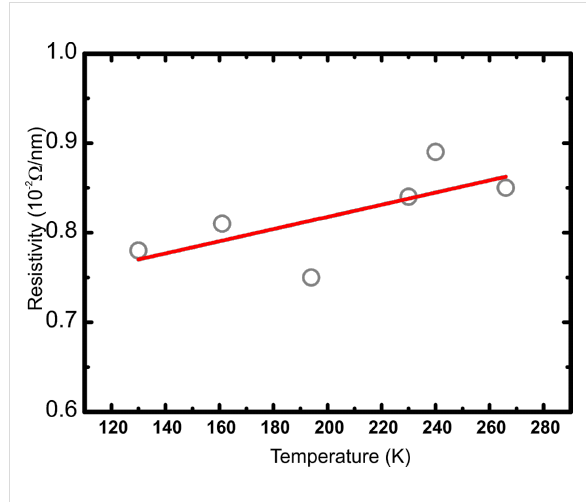
Figure 3: Resistivity, as evaluated from the gradient of the potential in the STP images, as a function of the temperature of the sample.